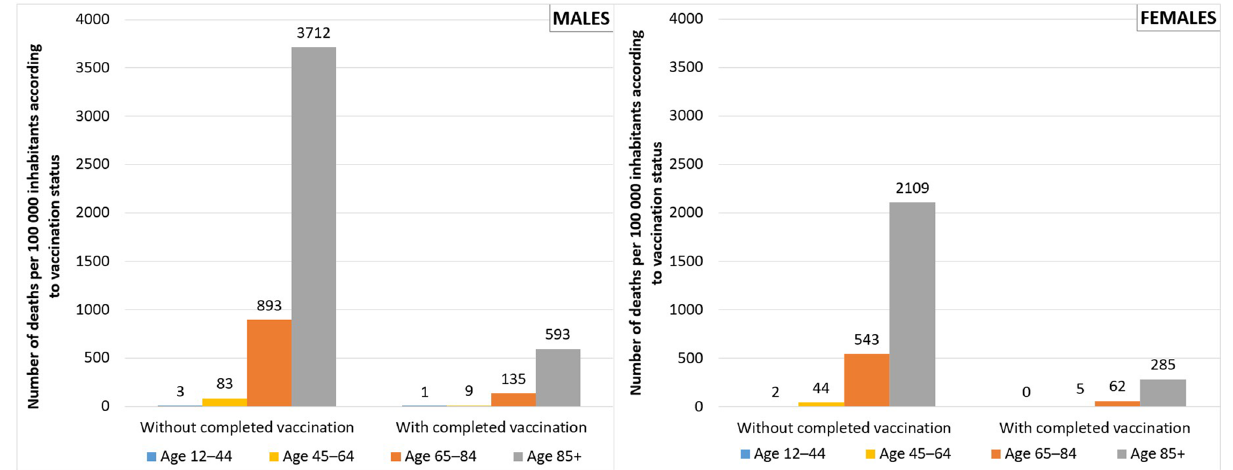
Figure 2. Number of deaths per 100,000 inhabitants according to vaccination—population with and without completed vaccination, males (left), females (right). Source: author’s calculation 11,15 .